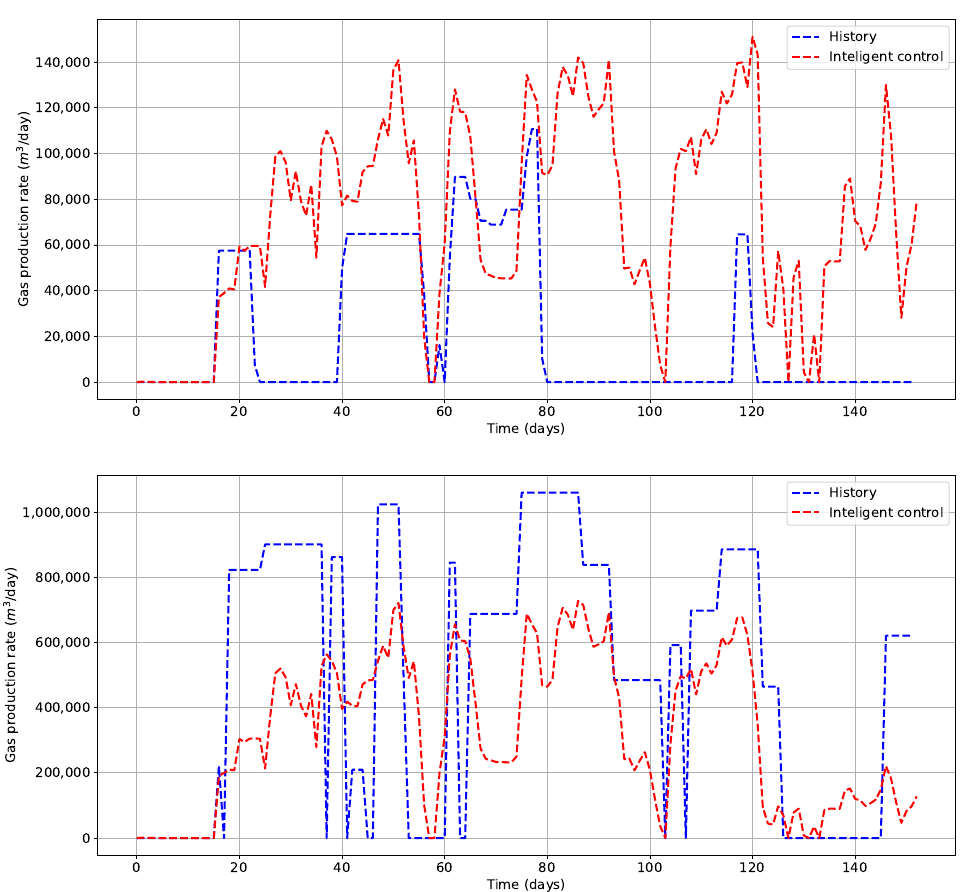
Figure 8. Influence of the developed control method on the gas production rate from P1 well ( top ) and P2 well ( bottom